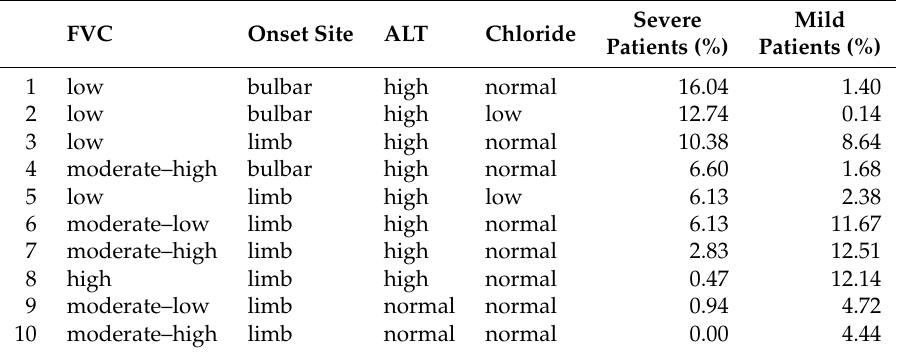
Table 7. Six most frequent value combinations for severe and mild patients for Swallowing (note that combinations 3 and 6 are shared by the two patient groups).